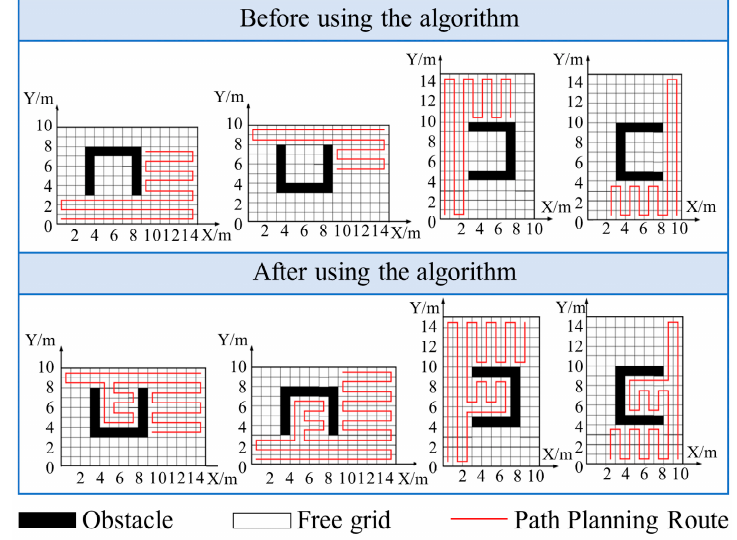
Figure 9. U-shaped obstacle avoidance strategy.